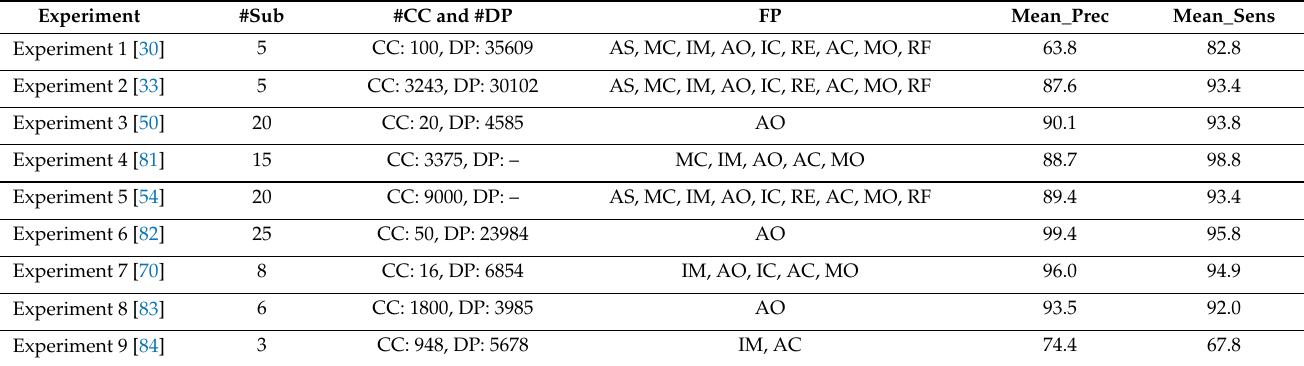
Table 4. Details of conducted experiments.